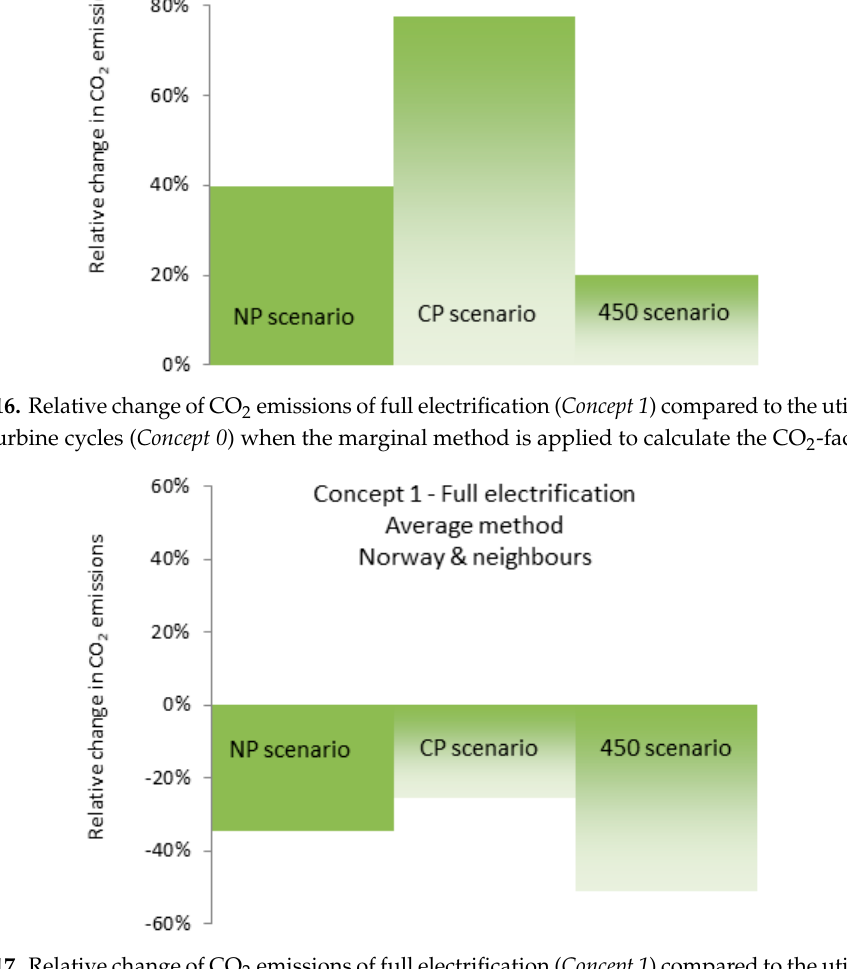
Figure 17. Relative change of CO 2 emissions of full electrification ( Concept 1 ) compared to the utilization of gas turbine cycles ( Concept 0 ) when the average method over Norway and neighbours is applied to calculate the CO 2 -factor.